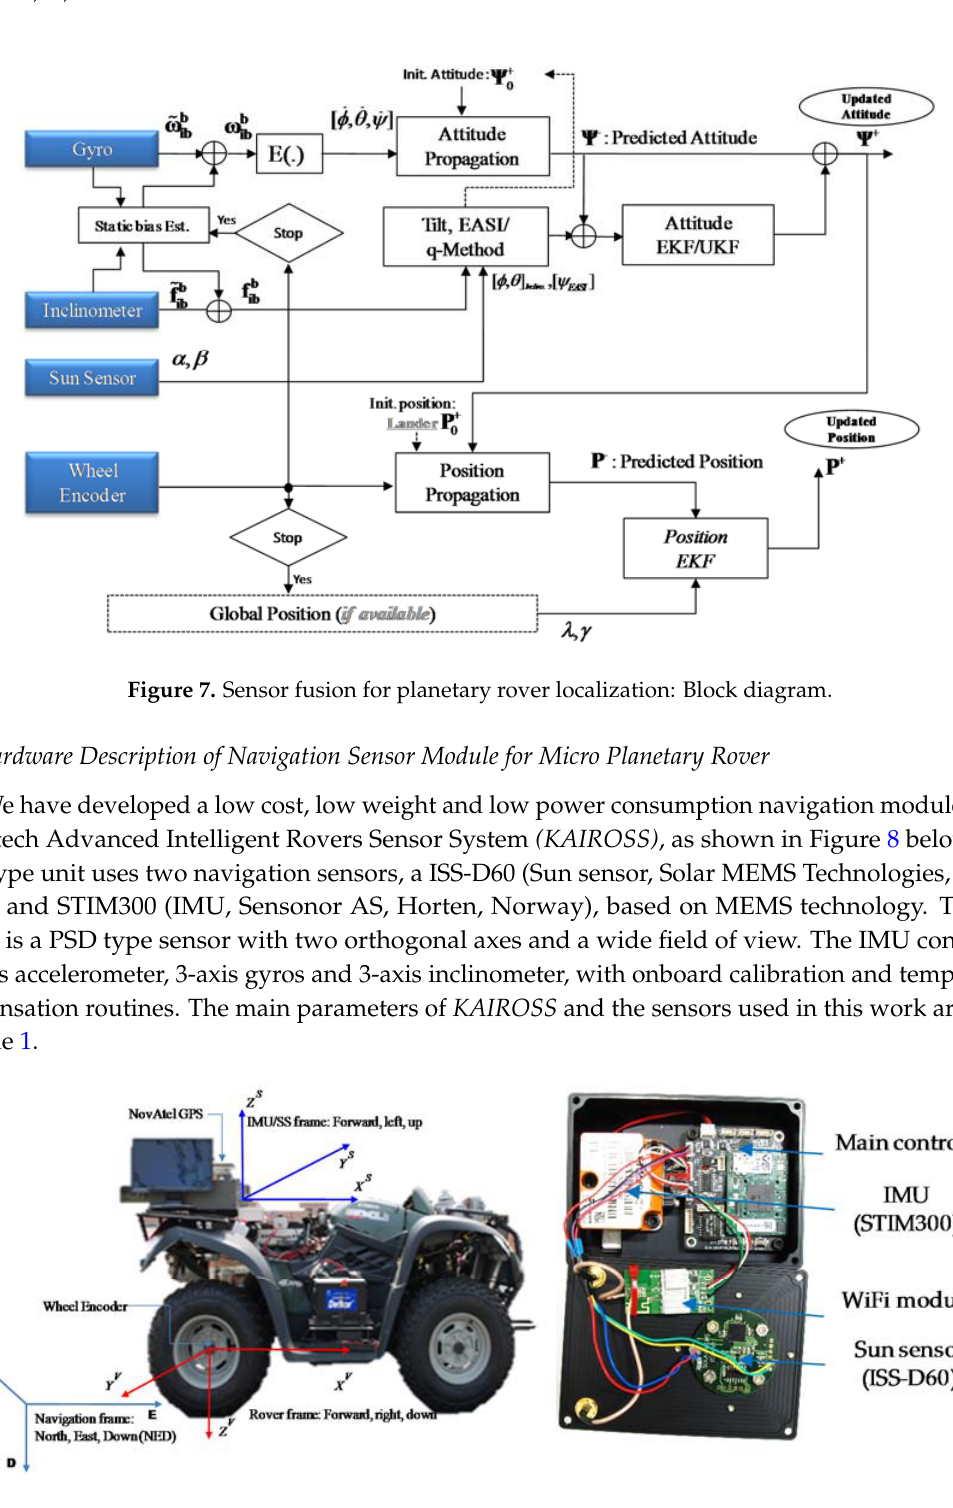
Figure 8. Left: Test rover. Right: Exploded view of the sensor module ( KAIROSS ) used for experiments. Table 1. Sensor parameters in KAIROSS .